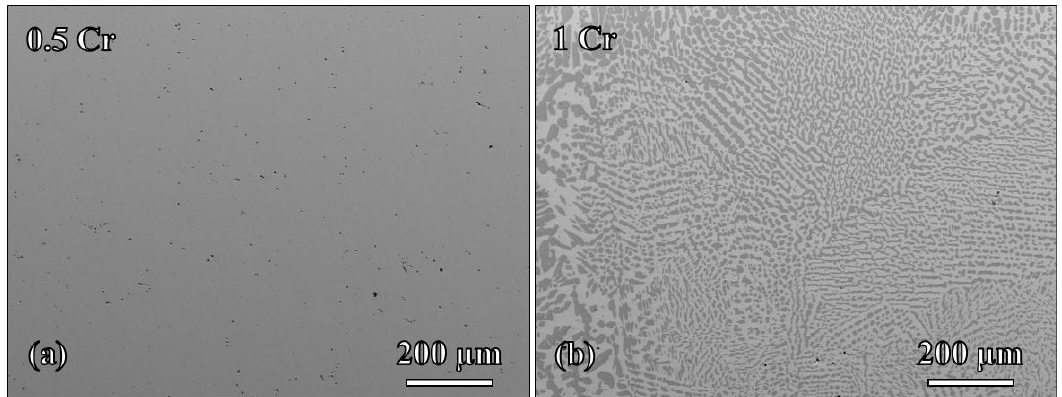
Figure 1. SEM-backscattered electron (BSE) micrographs taken from 0.5 Cr ( a ) and 1 Cr ( b ) alloys.